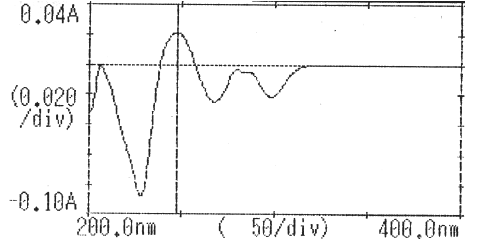
Figure 3. First order spectrum (N=1) of itopride hydrochloride in